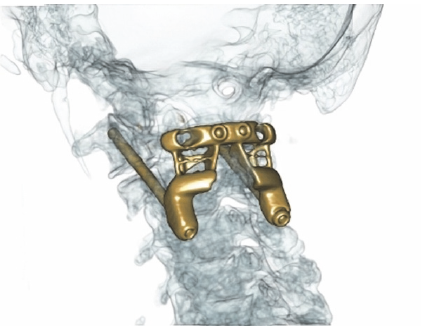
Figure6:CTwithproposed3DPtitaniumC1-C2prosthesisoverlaid (source: reproduced and adapted with permission from Phan et al.).